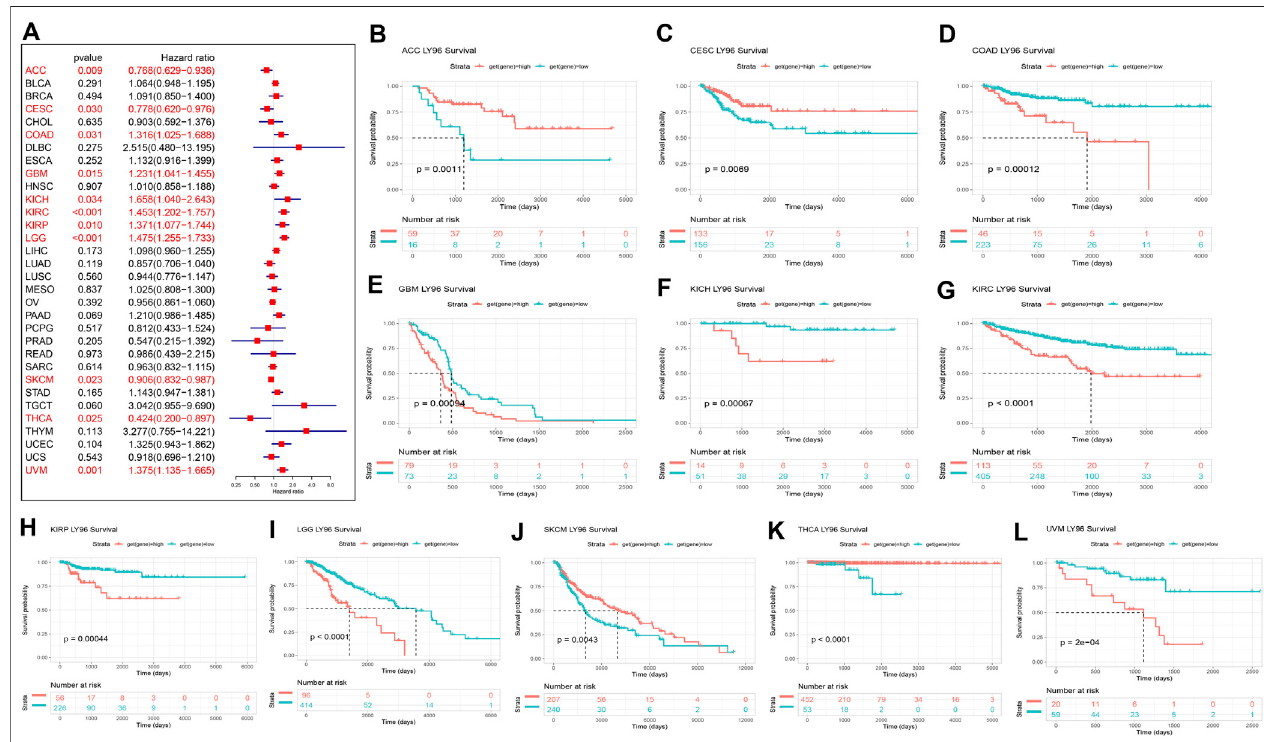
FIGURE 4 | Correlation between LY96 expression and disease-speci fi c survival (DSS). (A) Forest plot of LY96 expression and DSS across cancers. Kaplan – Meier analysis of LY96 expression and DSS in (B) adrenocortical carcinoma (ACC), (C) cervical squamous cell carcinoma, endocervical adenocarcinoma (CESC), (D) colon adenocarcinoma(COAD), (E) glioblastomamultiforme(GBM), (F) kidneychromophobe(KICH), (G) kidneyrenalclearcellcarcinoma(KIRC), (H) kidneyrenalpapillarycell carcinoma (KIRP), (I) brain lower grade glioma (LGG), (J) skin cutaneous melanoma (SKCM), (K) thyroid carcinoma (THCA), and (L) uveal melanoma